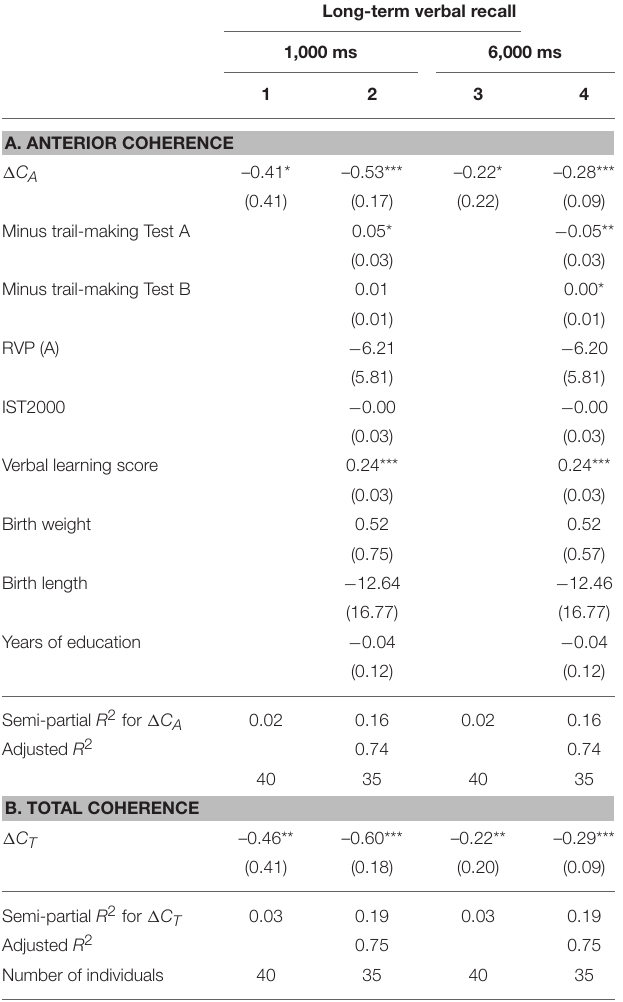
TABLE 6 | Linear regression of the long-term memory and difference between monomodal and bimodal coherence ( 1 C ) when investigating the effect of different time windows.